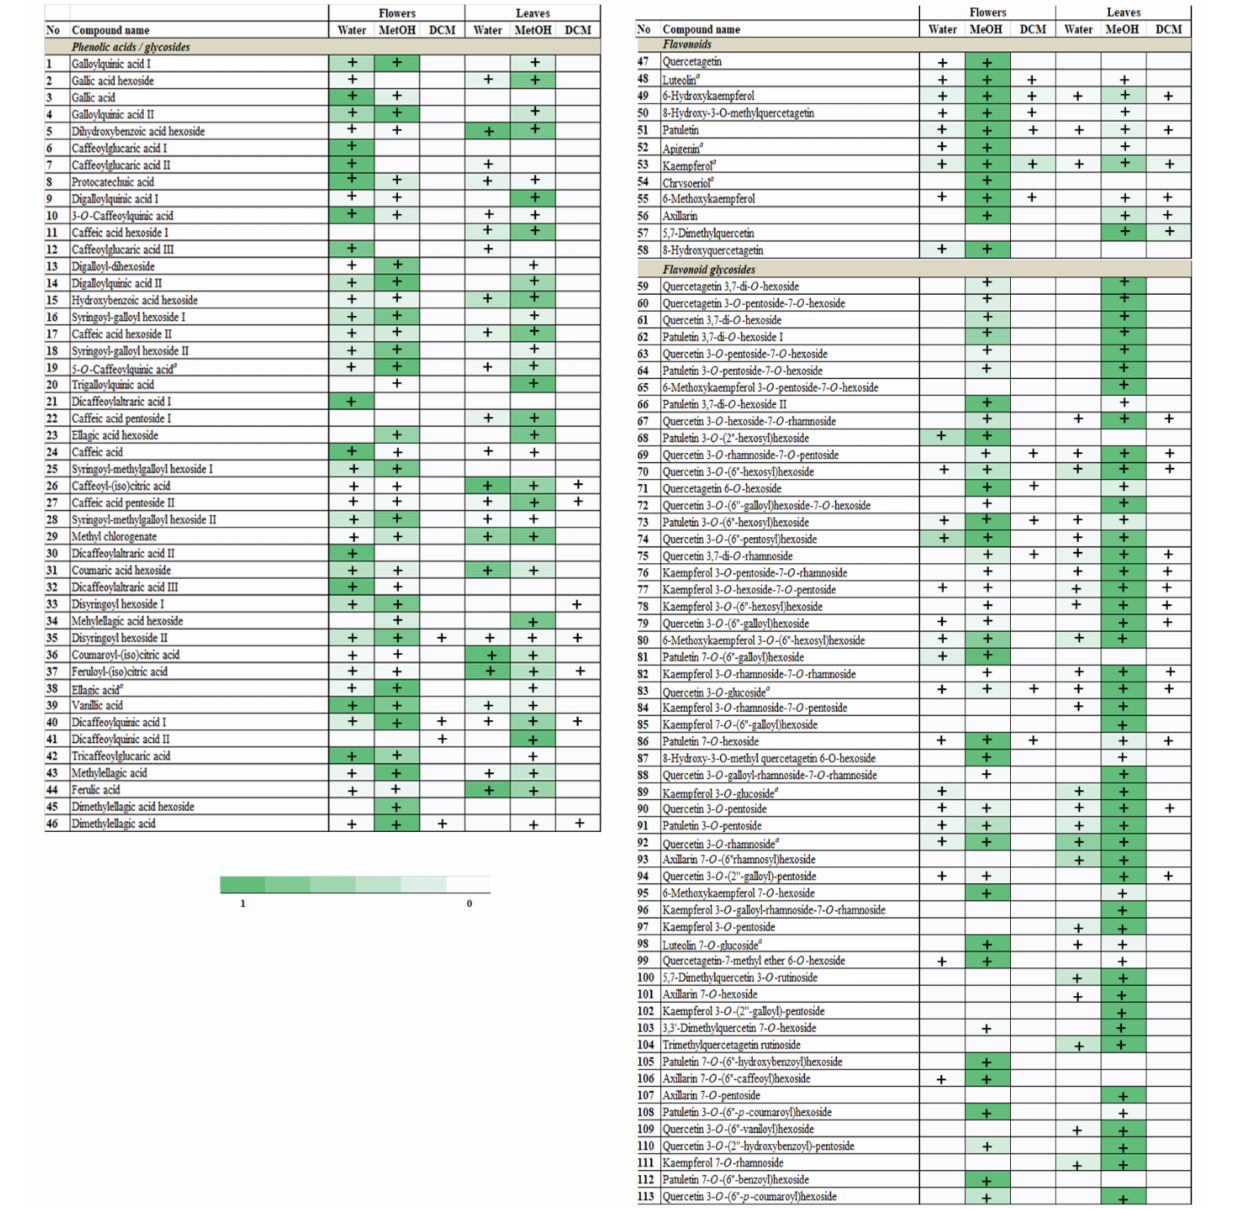
Figure 2. Distribution of different phenolics in extracts of French marigold flowers and leaves obtained in water, methanol (MeOH), and dichloromethane (DCM). Heatmaps represent values for scaled areas obtained from full scan MS for each compound (1 in the color legend corresponds to the maximal peak area detected for each